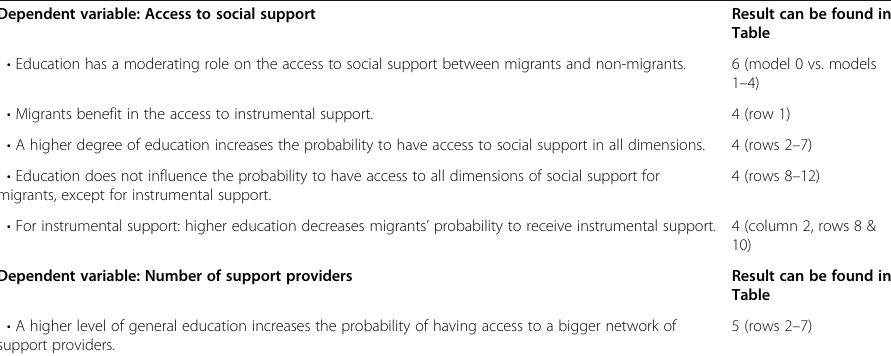
Table 3 Overview of the results Dependent variable: Access to social support Result can be found in